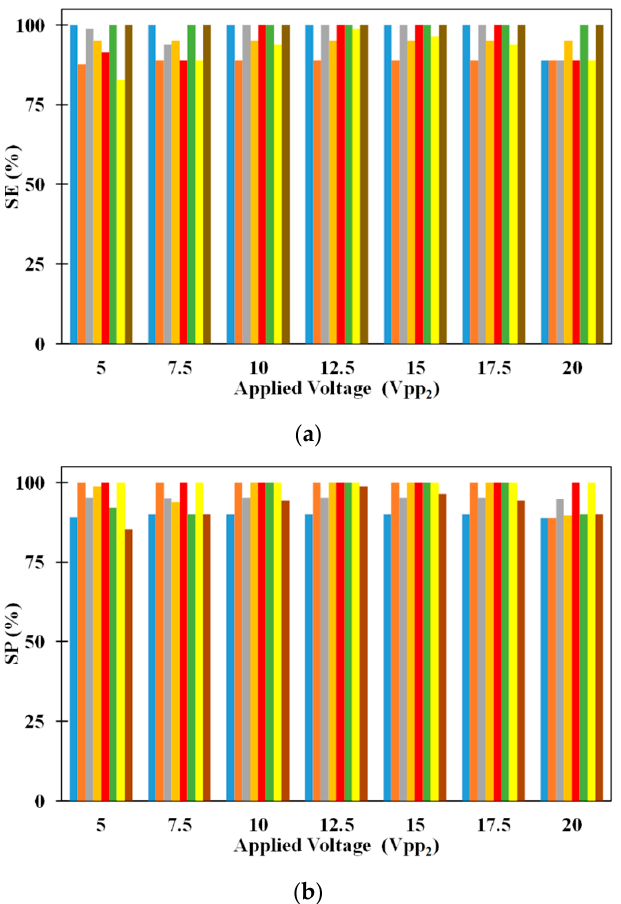
Figure 6. Influence of volumetric flow rate on ( a ) SE and ( b ) SP for Q m = 50 μ L/h ( ■ : 2.5 μ m, ■ 5 μ m), Q m = 100 μ L/h ( ■ : 2.5 μ m, ■ 5 μ m), Q m = 200 μ L/h ( ■ : 2.5 μ m, ■ 5 μ m), and Q m = 300 μ L/h ( ■ : 2.5 μ m, ■ = 100 µ m, H = 100 µ m, V = 20 V = N = 192.8 5 μ m); n = 30, W ch = 100 μ m, H ch = 100 μ m, V pp1 = 20 V pp , N = N cr,5 = 192.8 kHz. (cid:4) 5 µ m); n = 30, W pp , N ch ch pp1 cr,5